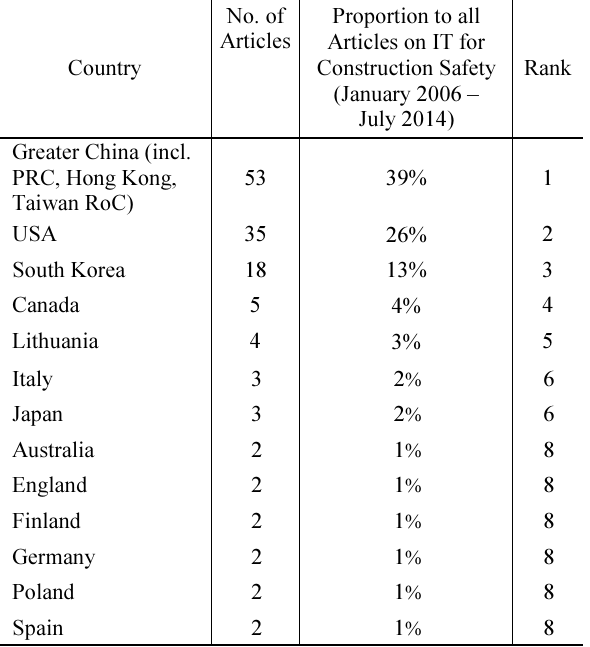
Table 2. Countries of origin of articles on IT in construction safety (per origin of the corresponding author)